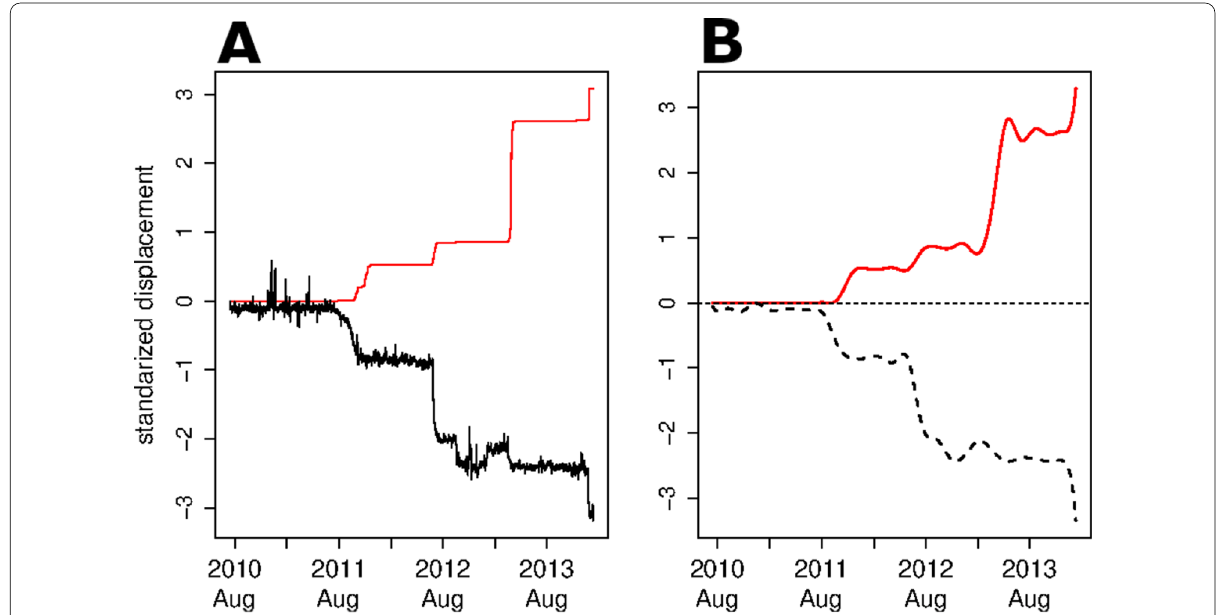
Fig. 7 Standardized displacement and the cumulative energy released data series ( A ) and the associated curves with the optimal parameters ( B ). In this figure it is easy to see the relationship that exists between the